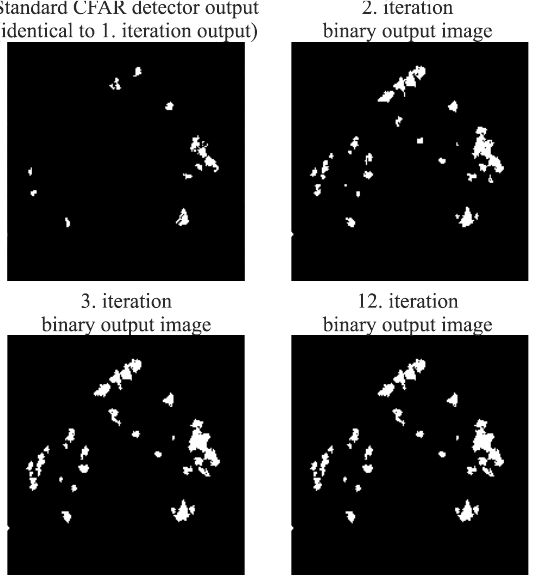
Figure 4. Iterative CFAR detector applied to the example iceberg cluster shown in Figure